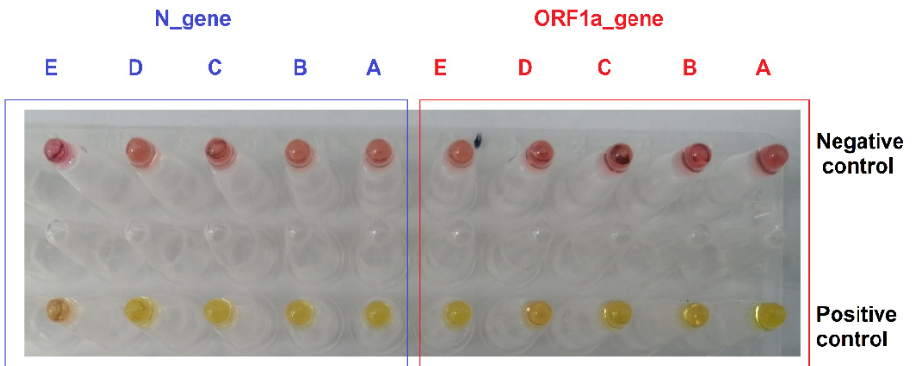
Figure 2. RT-LAMP with five primers targeting ORF1a and N gene using DNA fragment. The first row is the negative control reactions that contained no DNA template. In contrast, the second row is the RT-LAMP positive control assay performed against a synthesized viral cDNA fragment. The pink color indicates negative reactions, while the yellow denotes positive reactions.